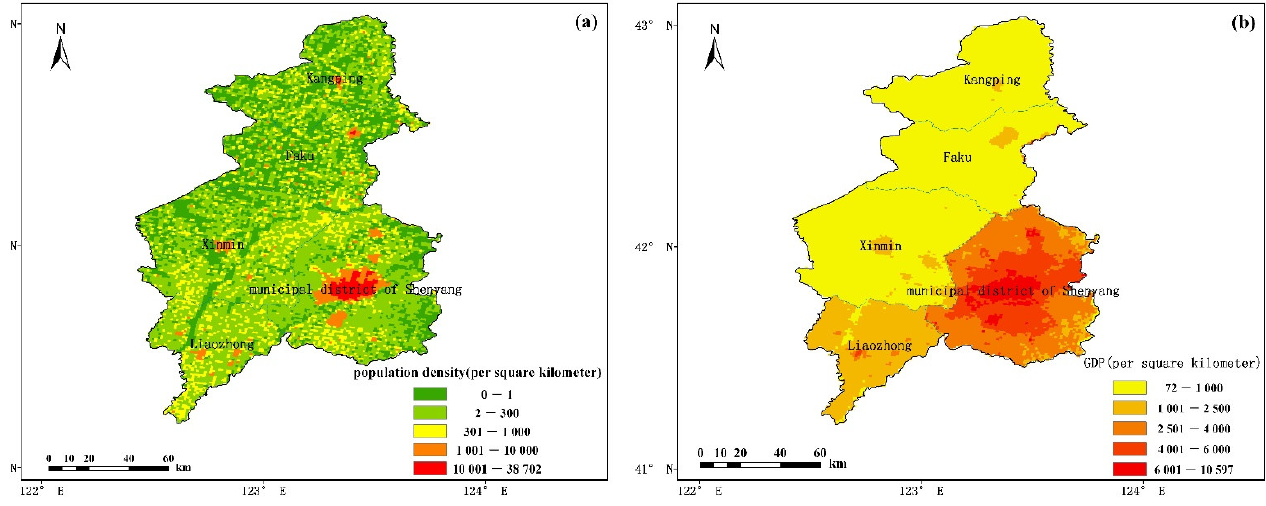
Figure 4. Spatial distributions of ( a ) population density and ( b ) gross domestic product per unit area in Shenyang.